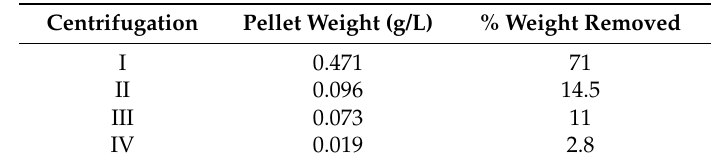
Table 1. Pellet weight post centrifugation.